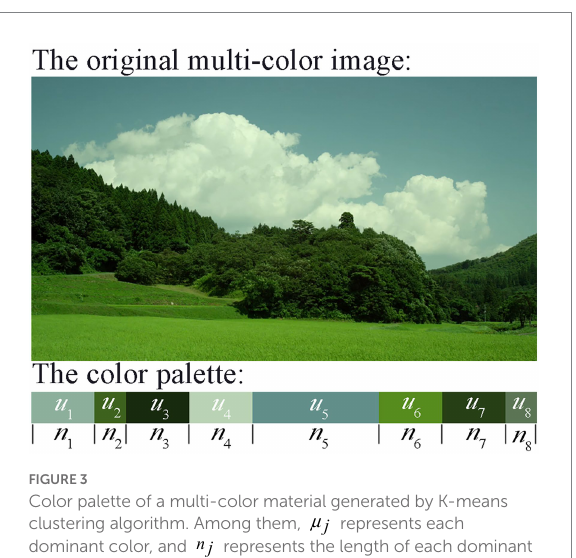
FIGURE 3 Color palette of a multi-color material generated by K-means clustering algorithm. Among them, j µ represents each dominant color, and n j represents the length of each dominant color in the color palette. j is set to